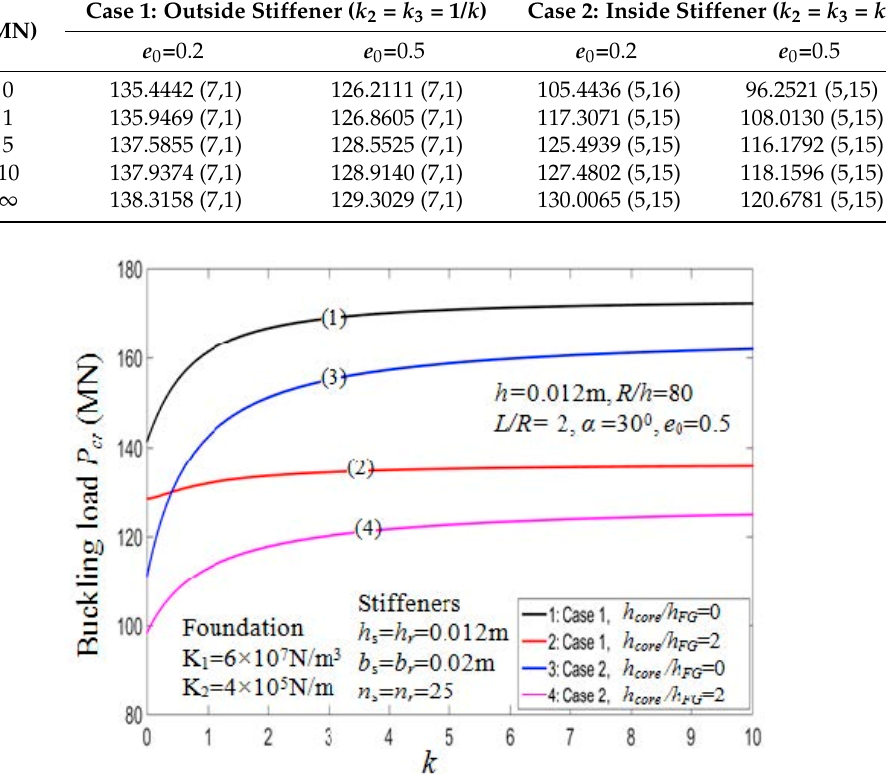
Figure 10. Effects of volume fraction indexes on critical load P cr ( k 2 , k 3 = 1/ k ).